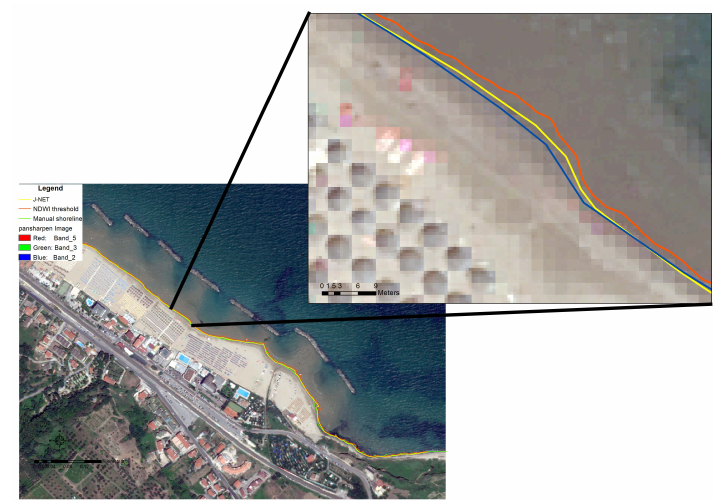
Figure 6. WorldView-2 image with three shorelines: the red line is the manually extracted shoreline; the yellow one is generated using the WVWI and the blue one from the J-Net Dynamic algorithm.